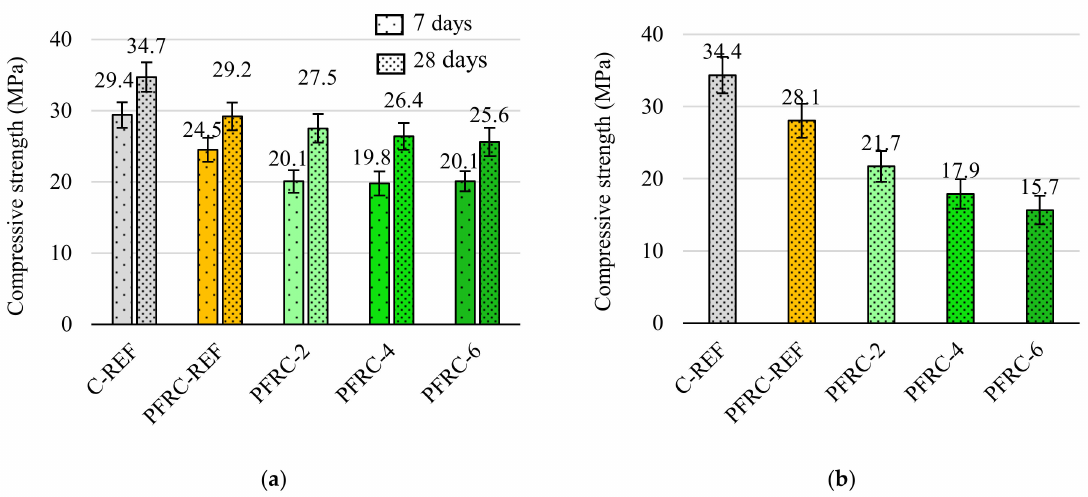
Figure 2. Compressive strength values for each mixture, along with the standard deviation bands: at 7 and 28 days (f ck,cube ) ( a ); at 28 days (f ck,cyl ) ( b